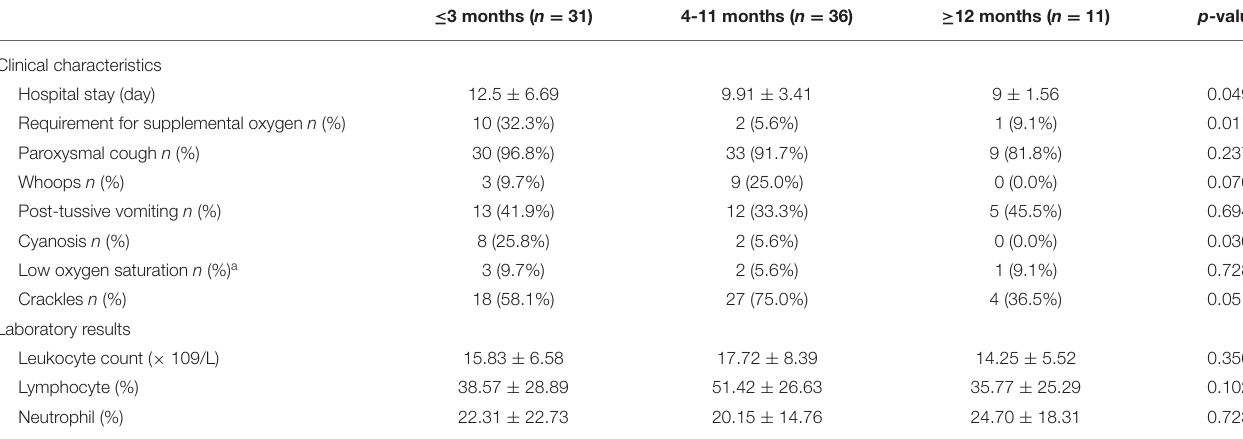
TABLE 3 | Clinical characteristics and results of laboratory examination among the different age groups with B. pertussis infection.